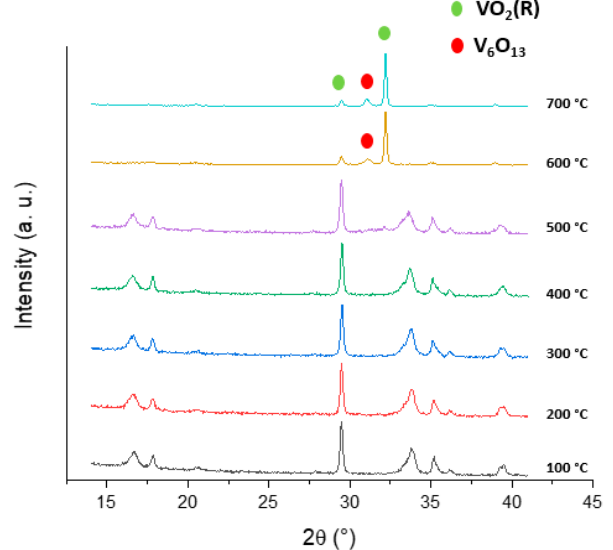
Figure 3. Superimposition of the temperature-dependent XRD patterns of the V5 1.7 _12h sample (Co anode).